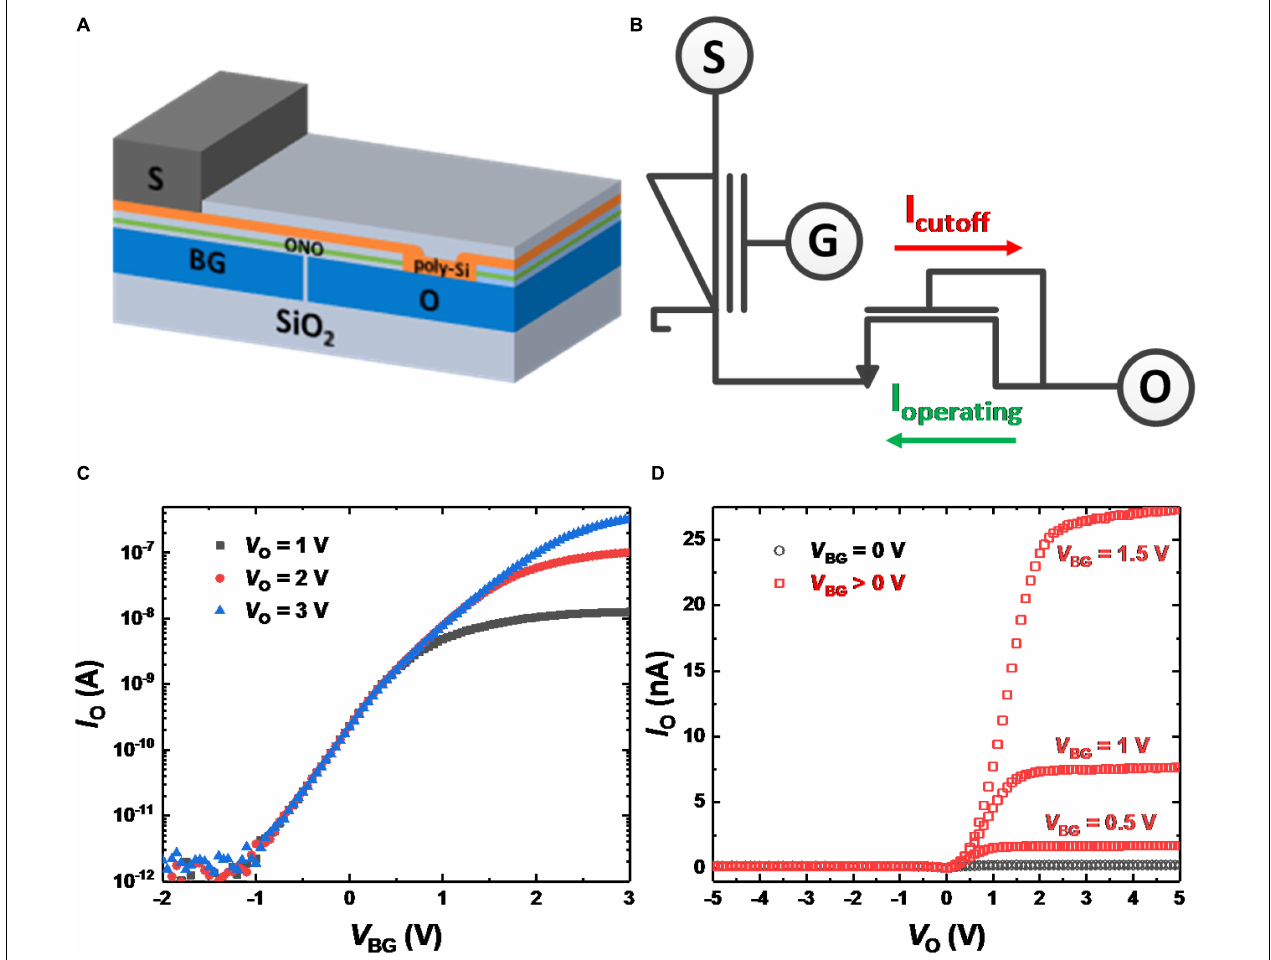
FIGURE 1 | (A) Bird’s eye view of a GSD. (B) Circuit diagram of a GSD. When V BG is positive, operating current flows with positive V O , and the current is cut off with negative V O . (C) Measured I O - V BG curves of GSDs with different V O values. (D) I O - V O curves of GSDs with different V BG values. When V O is positive, saturated current is shown as V O increases. Since a negative V O depletes electrons in the poly-Si active layer, the I O current is cut off.